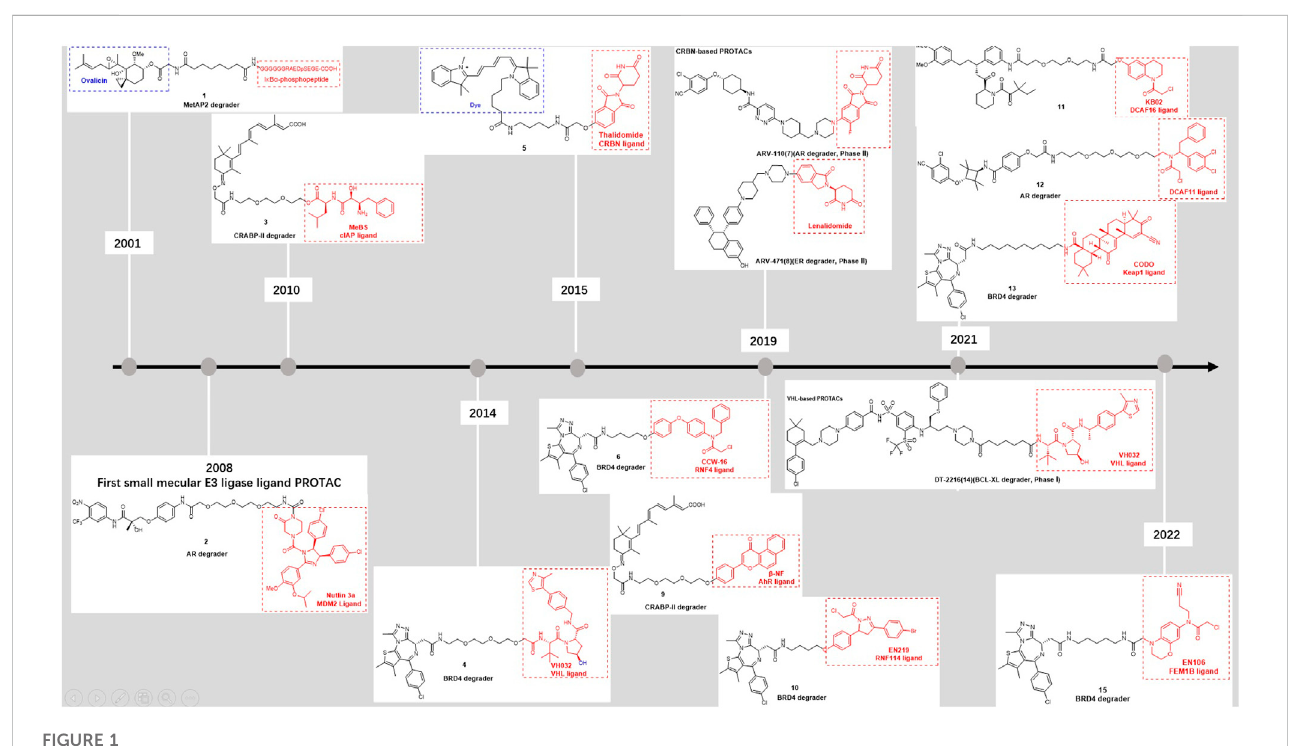
FIGURE 1 Timeline of E3 ligases ligands